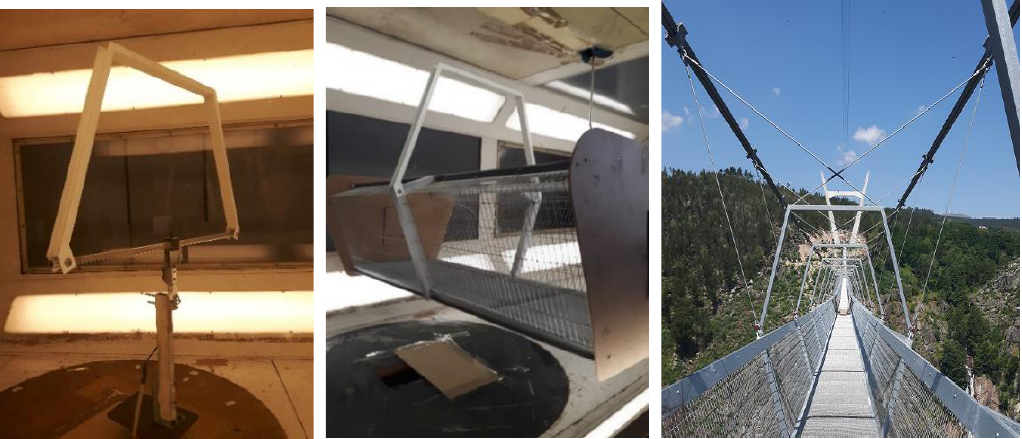
Figure 8. Testing the arch, the deck with the arch, and the real system with the secondary